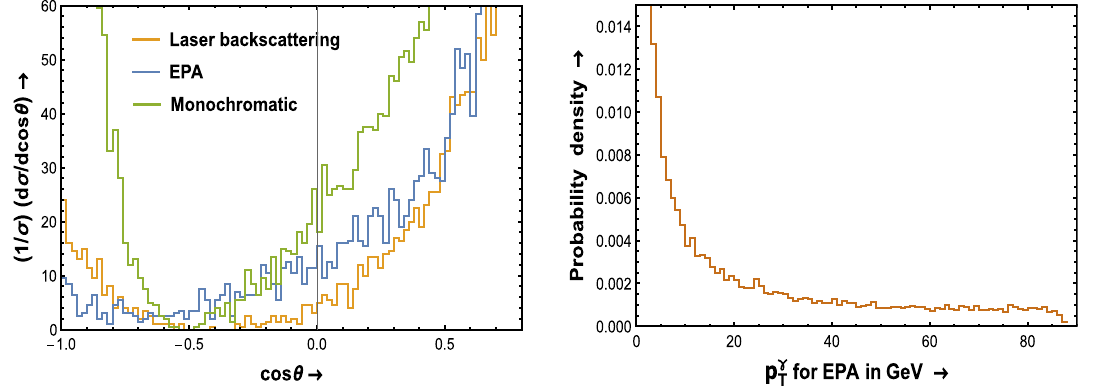
√ / 3 ) c in the BP1 scenario at s = 0 . 2 TeV is for the production of ( ˜ V + 1 2 μ shown in the left panel. The distribution for the transverse momentum of photon from a 100 GeV positron under the EPA scheme is shown in ) d cos θ the right